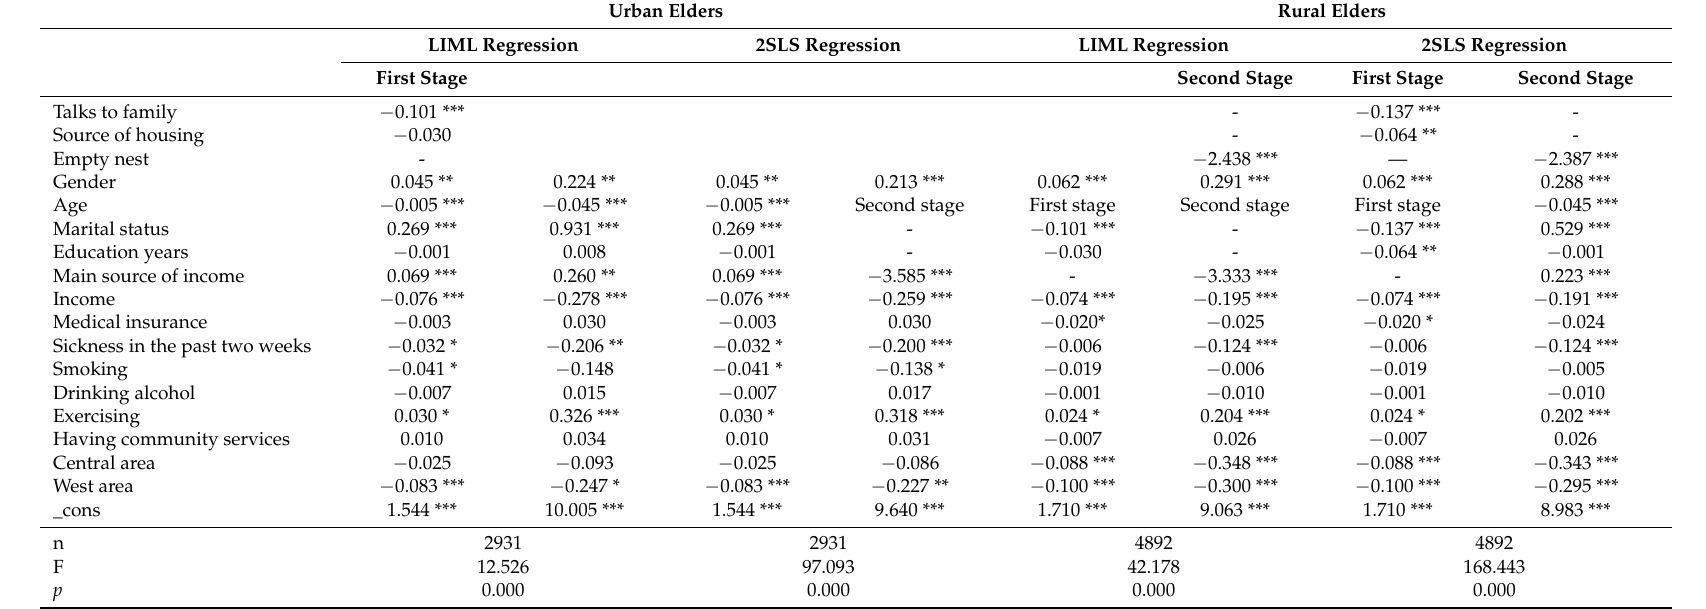
Table 4. Effects of an empty nest on urban and rural elders’ MMSE scores. Urban Elders Rural Elders LIML Regression 2SLS Regression LIML Regression 2SLS